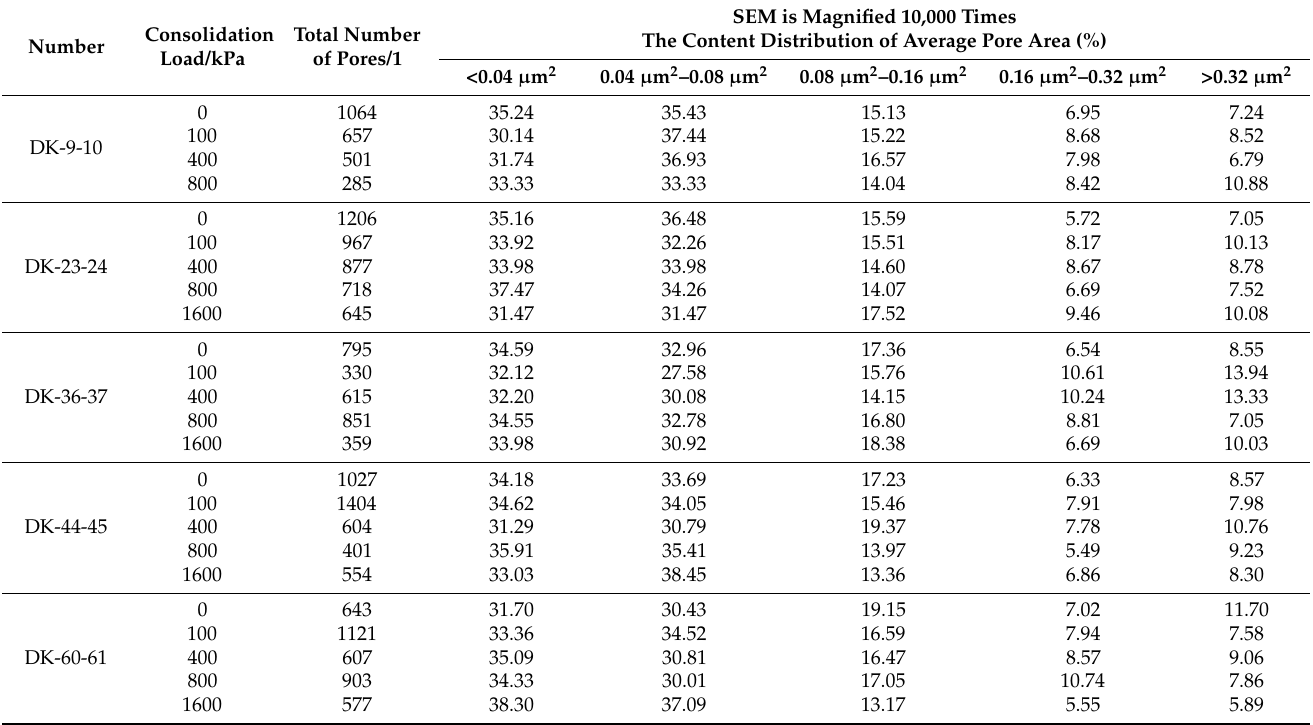
Table 4. Pore distribution under different consolidation loads (10,000-times